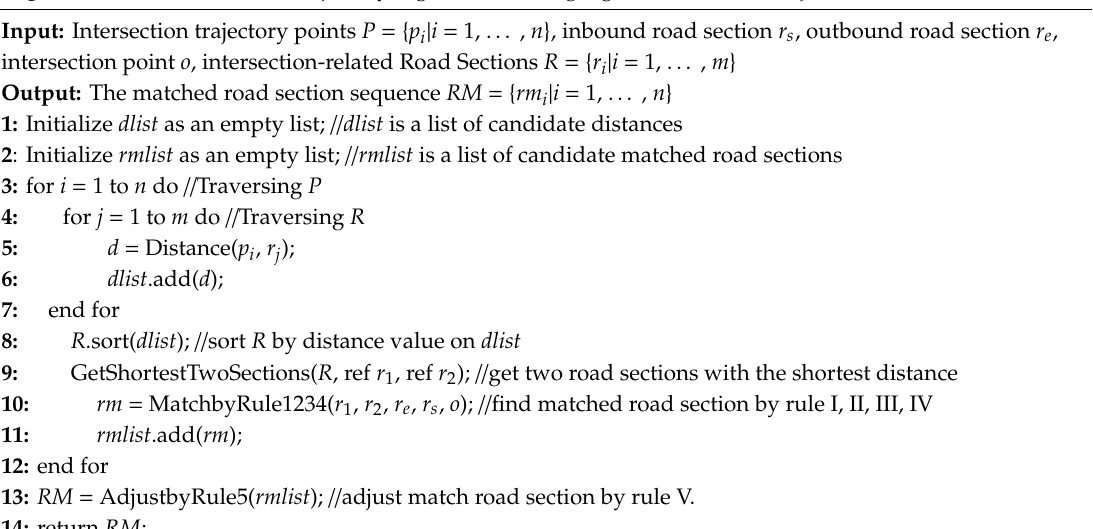
Algorithm 1 The intersection trajectory segment matching algorithm